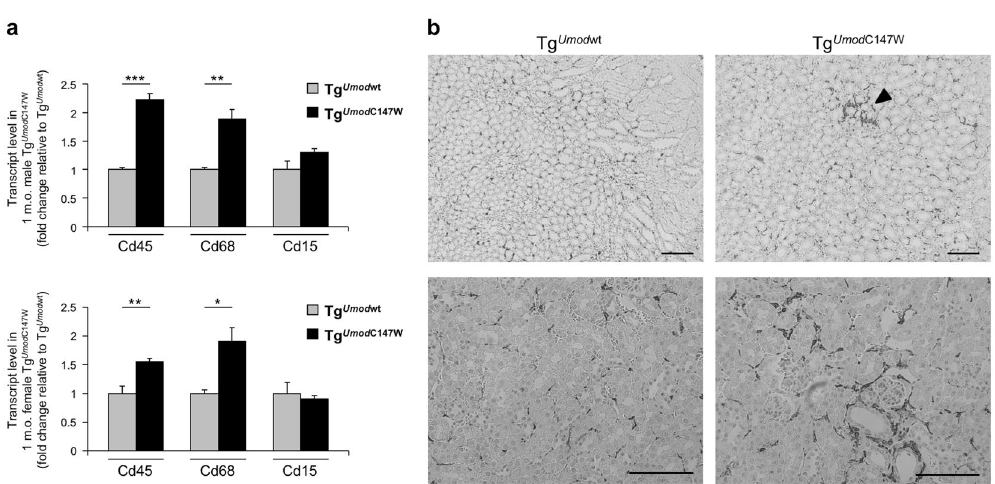
Figure 4. Characterization of infiltrating cells in kidneys of Tg Umod C147W mice at 1 month of age. ( a ) Analysis by RT-qPCR of the expression of markers of infiltrating cells in male (upper panel) or female (bottom panel) Tg Umod C147W mice relative to age- and sex-matched Tg Umod wt mice (n = 5/group). Cd45 ( Ptprc , common leukocyte marker), Cd68 (macrophage), Cd15 ( Fut4 , granulocyte) transcripts were highly expressed, while Cd5 (T cells) and Cd19 (B cells) were barely detectable (data not shown). Data are expressed as mean ± s.e.m. * P < 0.05; ** P < 0.01; *** P < 0.001 (unpaired t -test). ( b ) Representative immunohistochemistry (IHC) staining for macrophage marker F4/80 in kidneys of Tg Umod C147W and Tg Umod wt mice. IHC analysis shows focal increase (arrowhead) of macrophage infiltrate in Tg Umod C147W mice (scale bar 100 µ